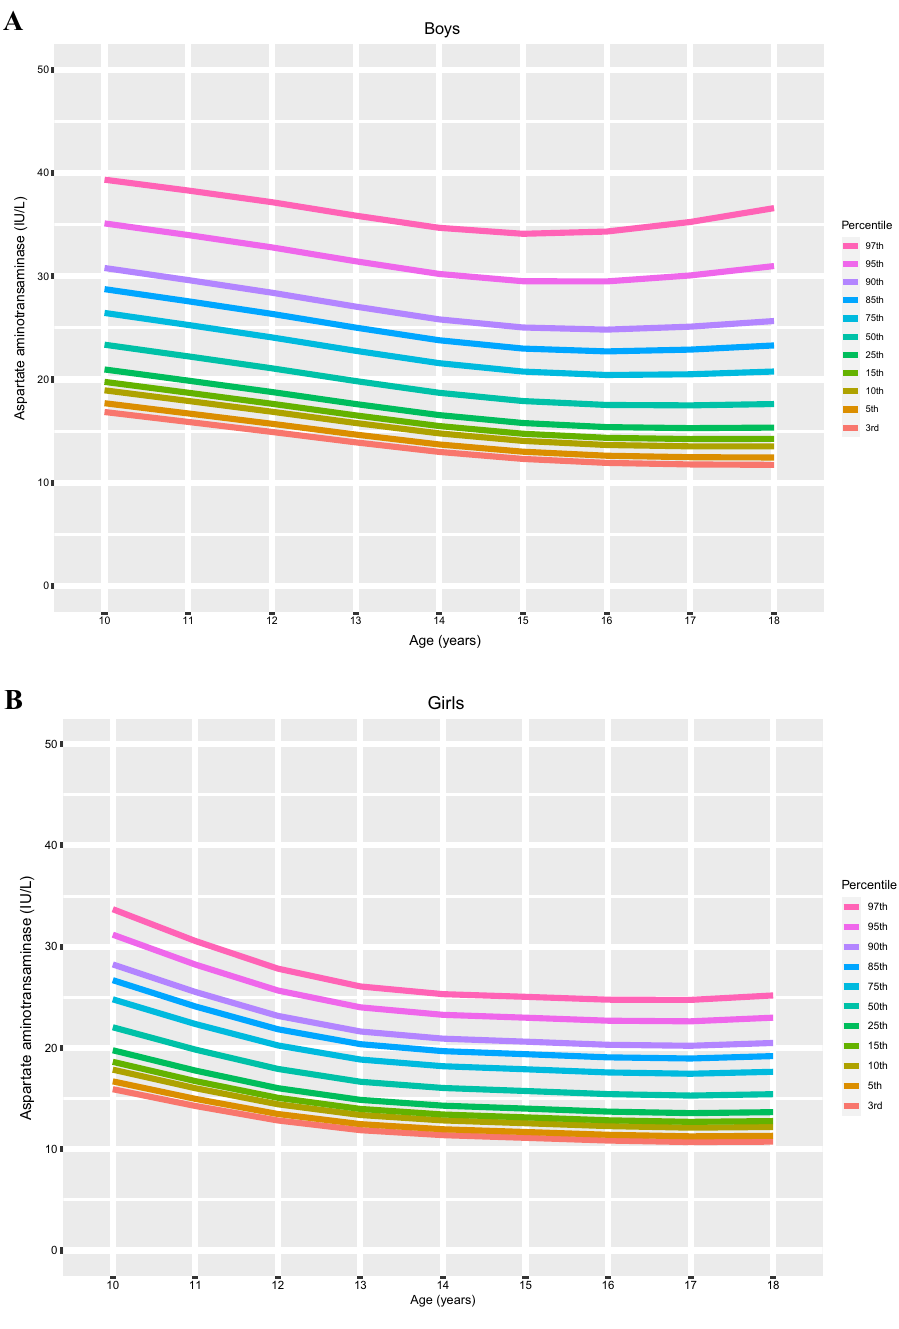
Figure 2. The distribution of sex- and age-specific percentiles for levels of AST, ALT, and the AST/ALT ratio in children aged 10–18 years ( n = 8091). Each figure represents the distribution of percentile by age of ( A ) AST percentile of boys, ( B ) AST percentile of girls, ( C ) ALT percentile of boys, ( D ) ALT percentile of girls, ( E ) AST/ ALT ratio percentile of boys and ( F ) AST/ALT ratio percentile of